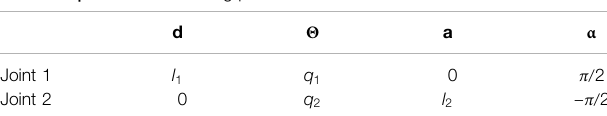
TABLE 2 | Denavit-Hartenberg